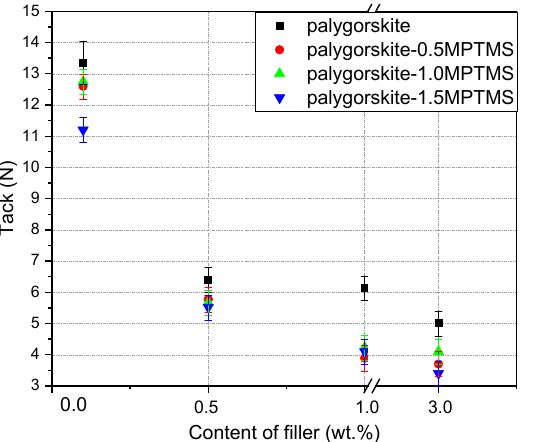
Figure 9. Influence of palygorskite modified by MPTMS addition on Si-PSA tape tack.